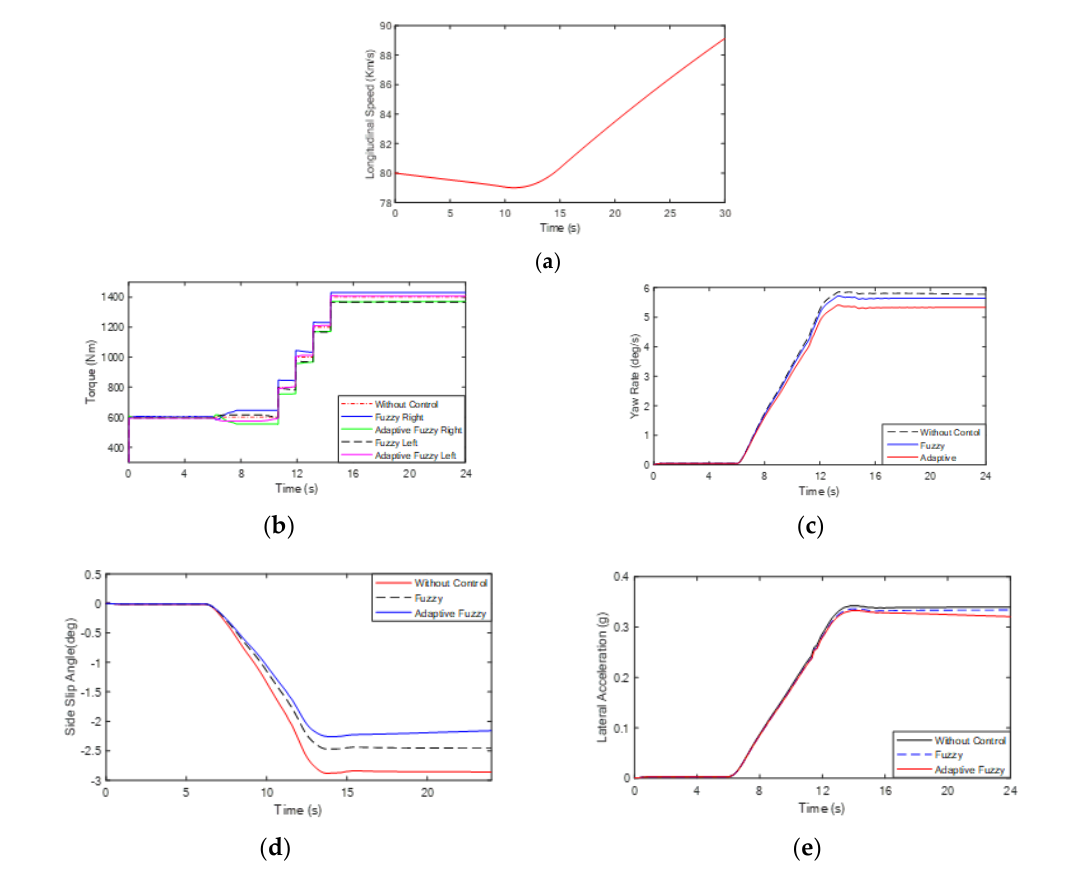
Figure 16. Acceleration pedal.